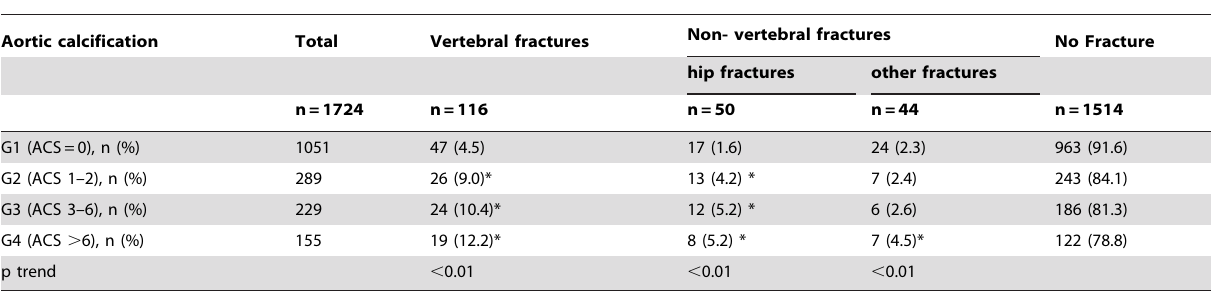
Table 2. Relationship between ACS groups and the fractures.